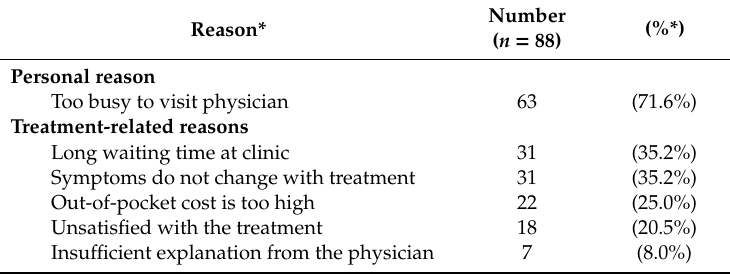
Table 2. The reasons for discontinuing ophthalmic